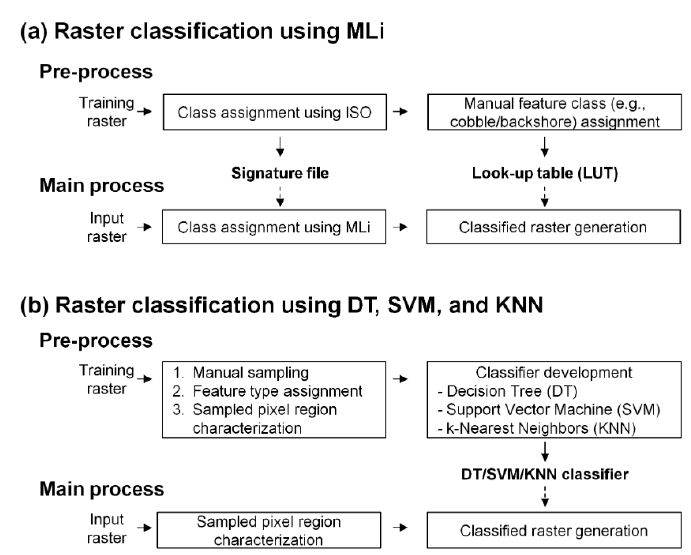
Figure 5. Pre- and main process flowcharts of supervised raster classification using ( a ) maximum likelihood (MLi), and ( b ) decision tree (DT), support vector machine (SVM), and k-nearest neighbors (KNN).